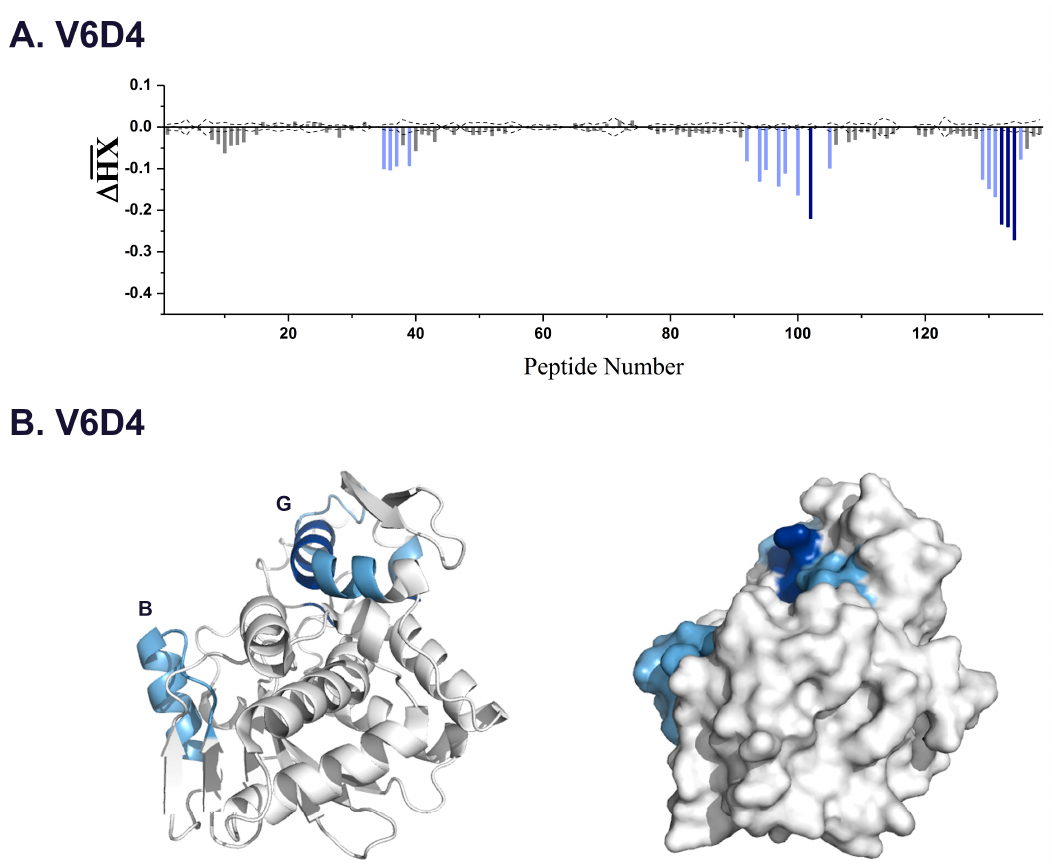
Figure 8. Epitope mapping of V6D4 from subcluster 3.3. ( A ) Relative levels of protection of RiVax peptides by V6D4 as defined by HX-MS. The color shading corresponds to strong (deep blue), intermediate (light blue) or no significant protection (gray), as represented in Figure 4. ( B ) The HX protection categories, as shown in panel A, were mapped onto the crystal structure of RiVax. Secondary structures α -helices B and G are labeled.